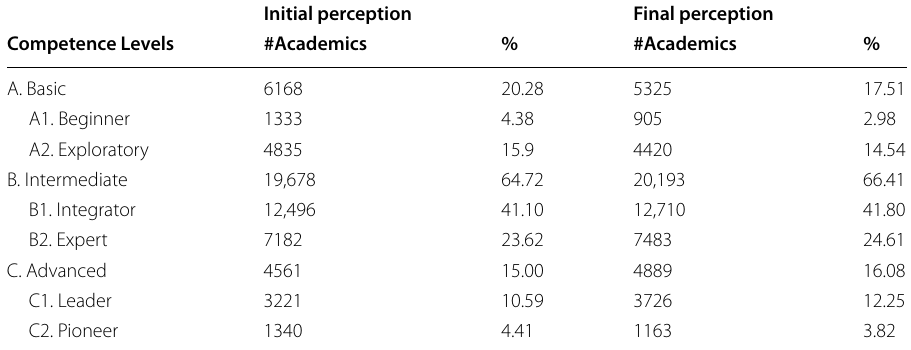
Table 3 Academics’ levels of digital competence, according to their initial and final perceptions Initial perception Final